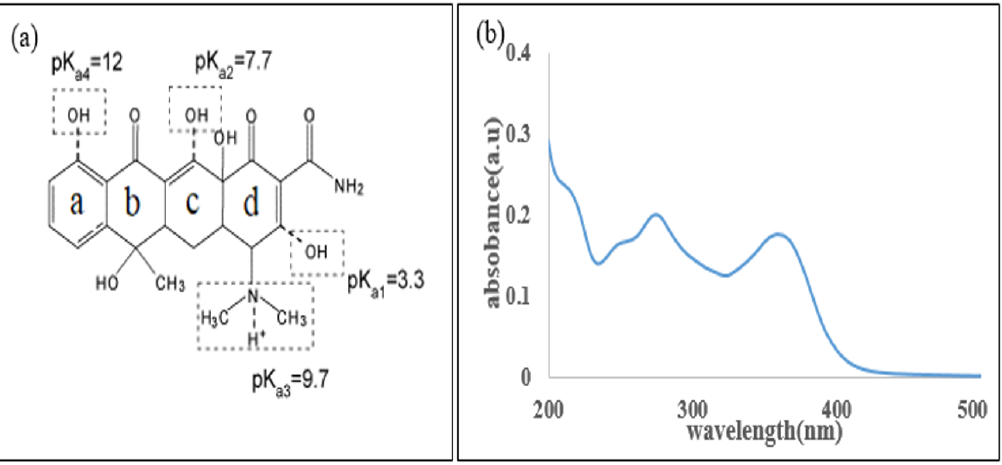
Figure 5. ( a ) Structure and ( b ) absorption spectrum of tetracycline